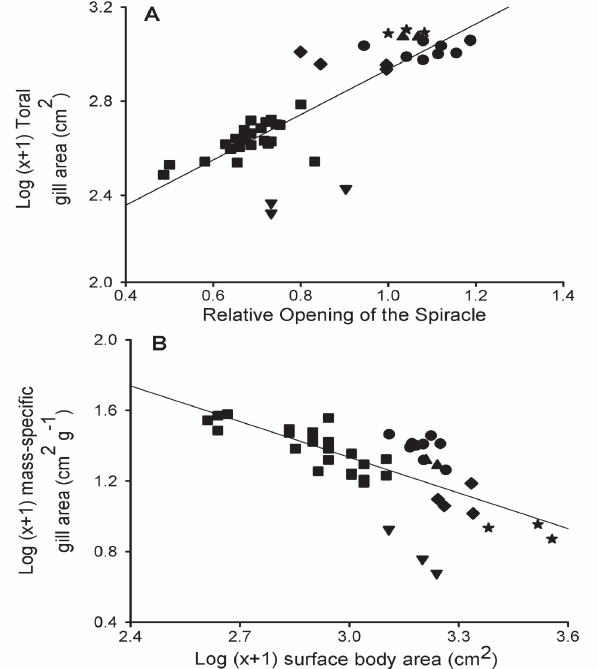
Fig. 7 . (A) The relationship between total gill area (cm 2 ) and Relative Opening of the spiracle. (B) Linear regression of the mass-specific gill area (cm 2 g -1 ) and body surface area (cm 2 ) of different potamotrygonid embryos: upsidedown triangle - Plesiotrygon iwamae ; star - Paratrygon aiereba ; diamond - Potamotrygon motoro (from Negro River); dot - Potamotrygon motoro (from Solimões River); triangle - Potamotrygon orbignyi ; square - cururu ray Potamotrygon sp.